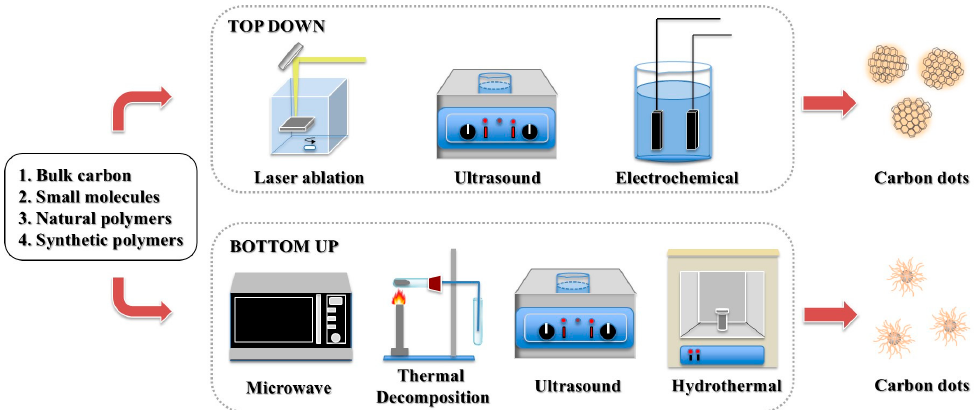
Figure 2. Common top-down and bottom-up approaches to synthesize carbon dots.